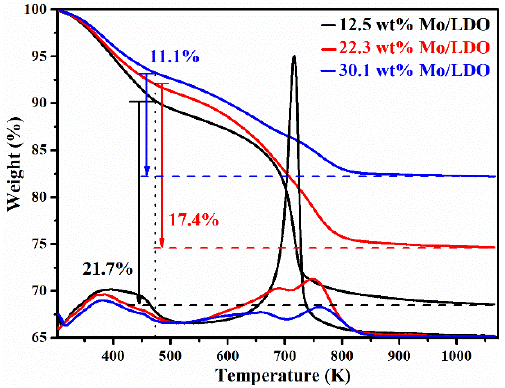
Figure 7. TG and DTG profiles of used Mo/LDO